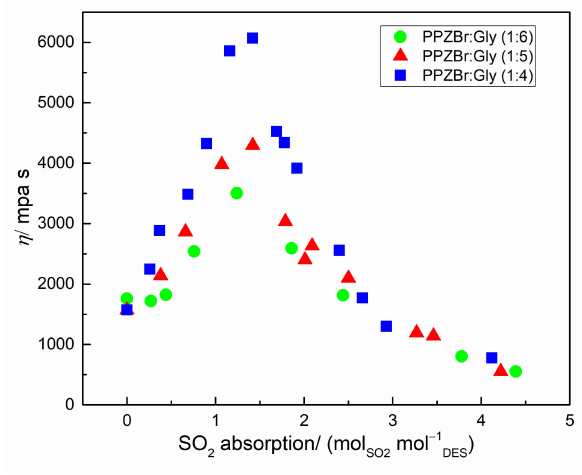
Figure 4. Viscosity of DESs as a function of the absorption amount of SO 2 . (Reprinted with permission from Ref. [54]. Copyright (2019) American Chemical Society).